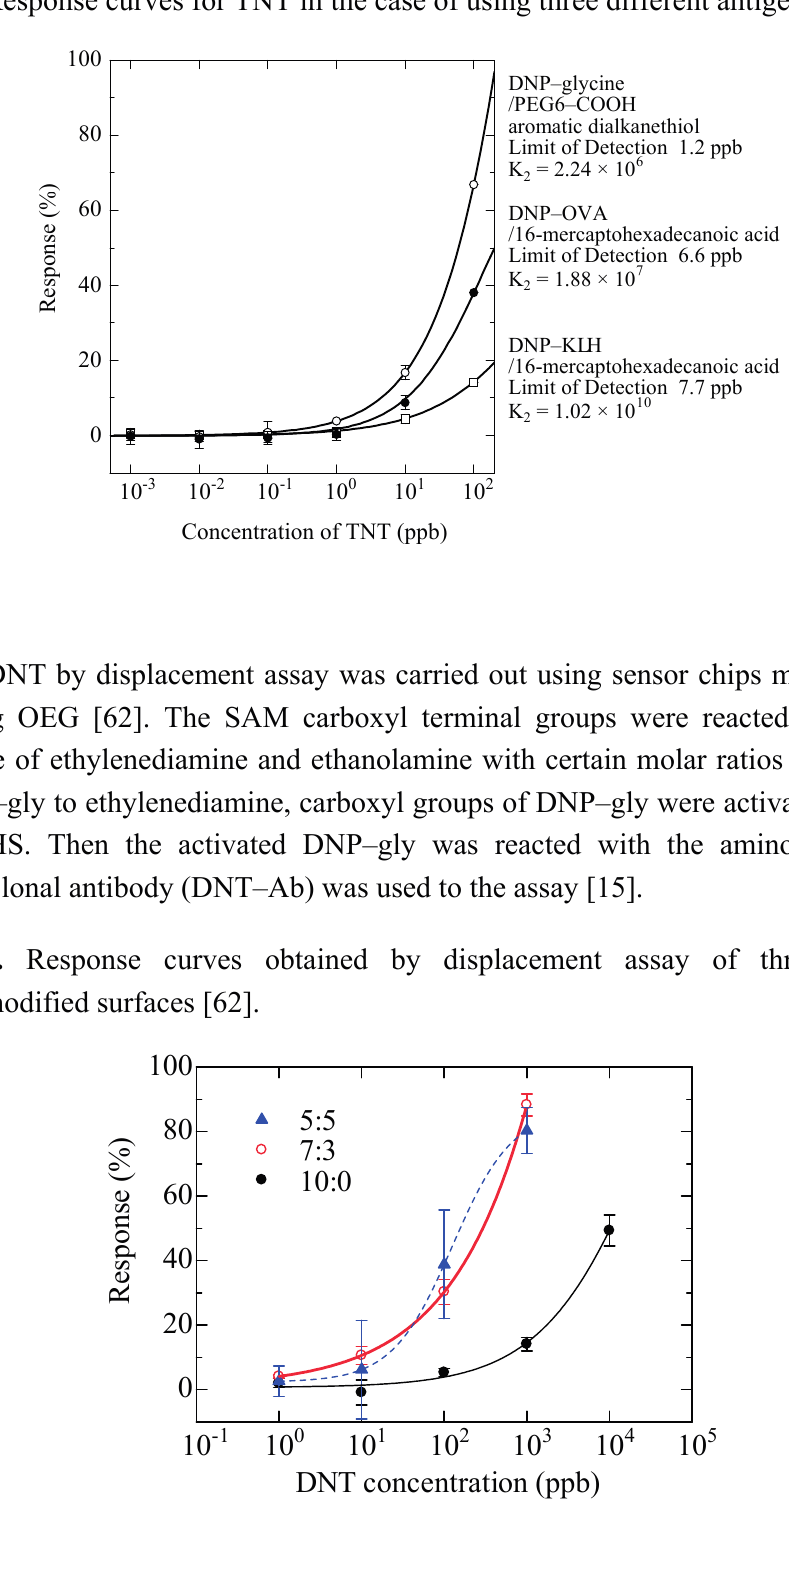
Figure 11. Response curves for TNT in the case of using three different antigen analogs [61].